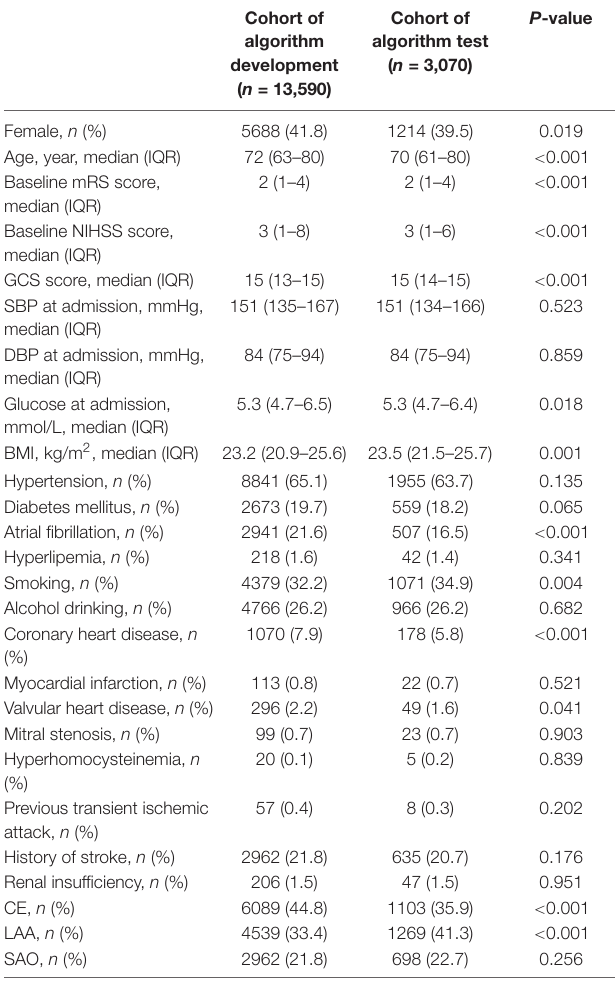
TABLE 1 | Comparison of clinical characteristics between a cohort of algorithm development and a cohort of algorithm test. Cohort of